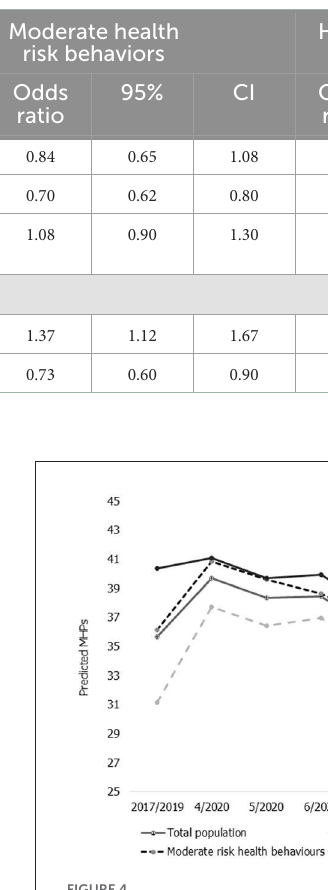
FIGURE4 Changes in MHPs during the COVID-19 pandemic by health behavior clusters. MHPs (scale 0–100) during the first year of the COVID-19 pandemic (4/2020–01/2021) in the UK. Relative to pre-pandemic measures 2017/2019 (fixed effects regression of the same person, adjusted for general changes in age, age-squared and weighted with each person’s last individual weight). Total population = the total